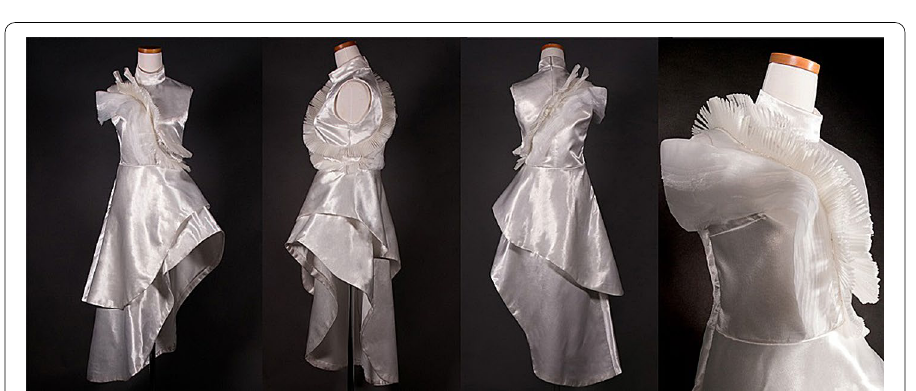
Fig. 3 Final product of ‘Design